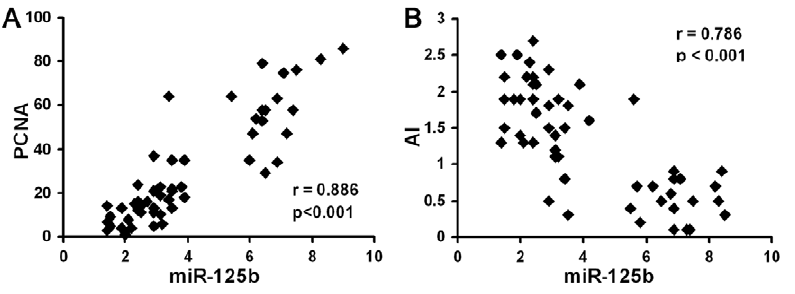
Figure 2. Circulating miR-125b expression correlated to chemotherapeutic response in breast cancer patients. Surgically removed tumor samples were obtained after neoadjuvant chemotherapy. (A) Percentage of PCNA positive cells was determined by immunohistochemical staining. (B) Apoptotic index (AI) was expressed as the percentage of TUNEL-positive tumor cells. Circulating miR-125b levels were determined by quantitative real-time PCR.